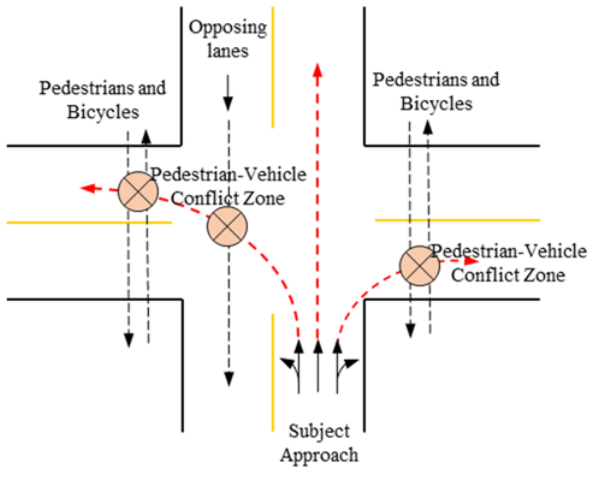
Figure 2. Conflict zone locations.